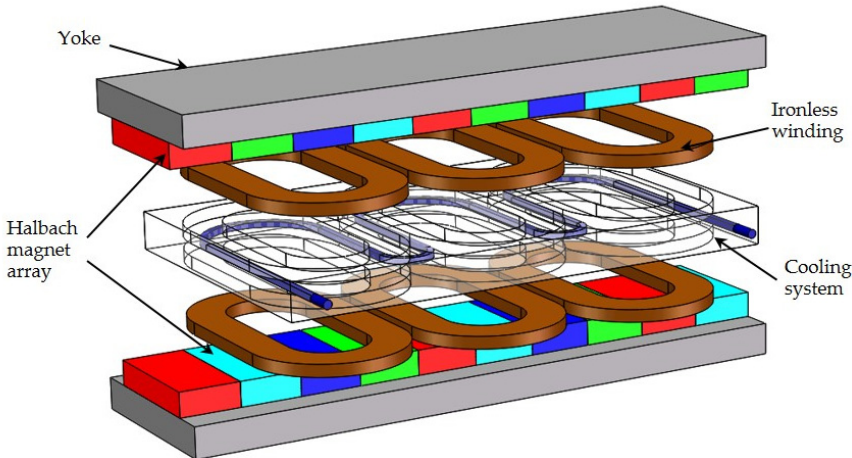
Figure 1. The novel ironless linear synchronous motor with cooling system.